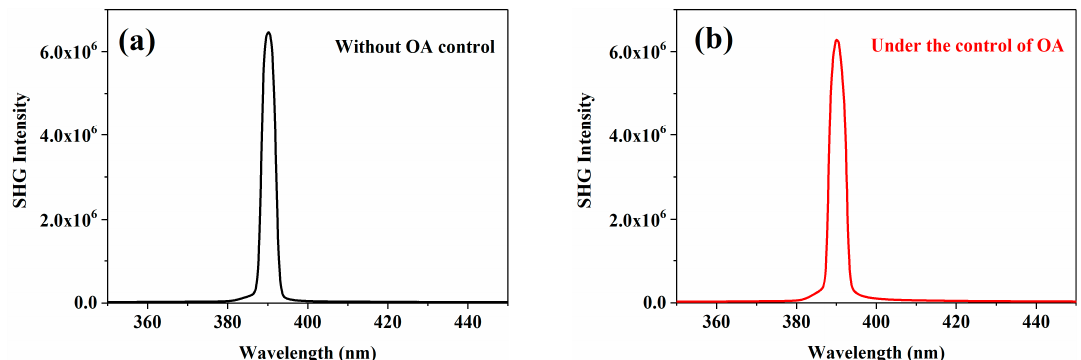
Figure 5. SHG spectra excited by a femtosecond pulse laser for the DAST single crystals grown ( a ) without the OA control; ( b ) under the control of the OA.